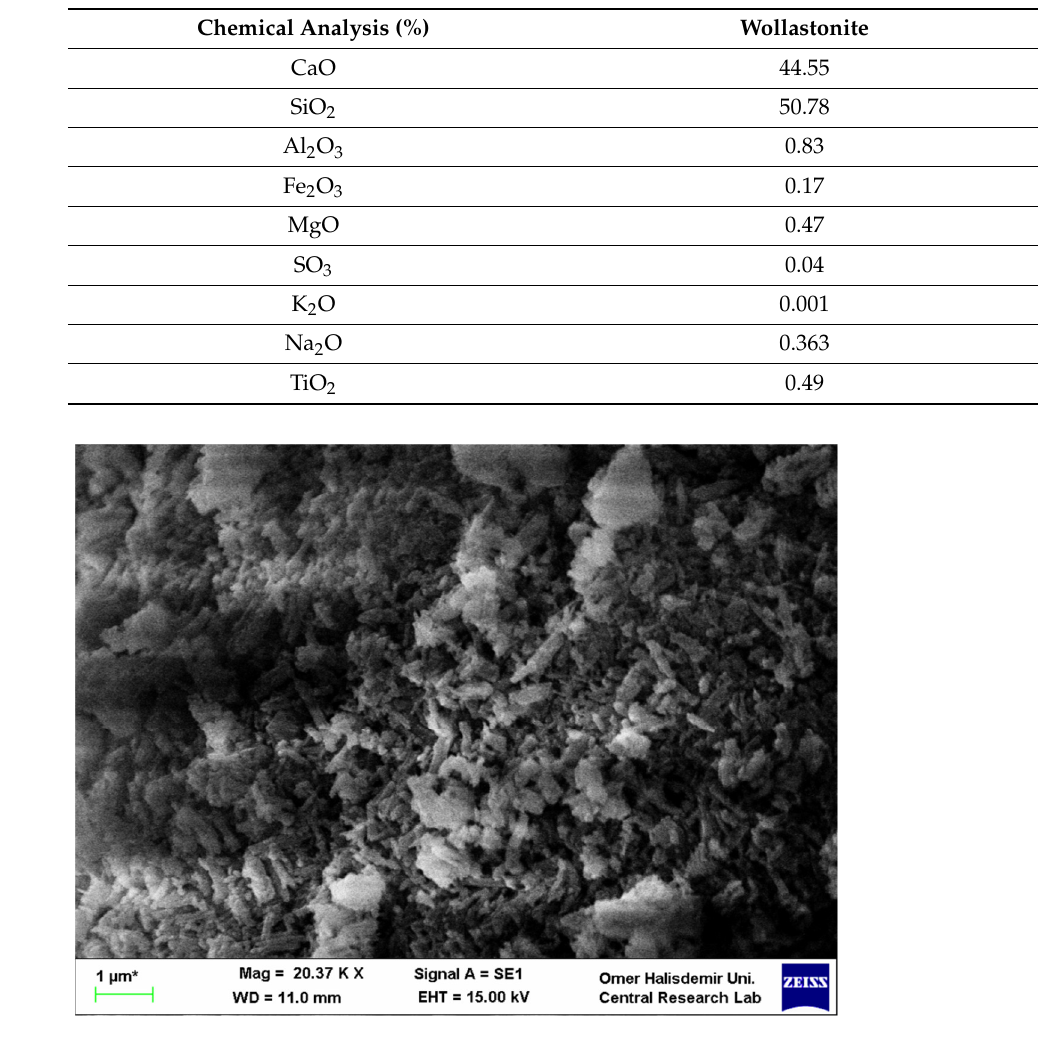
Figure 1. SEM image of